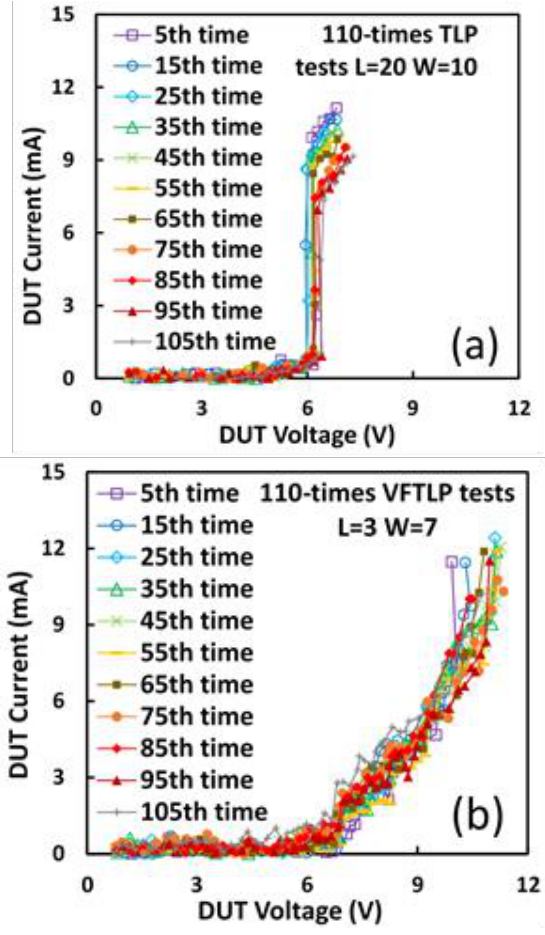
Figure 22. Durability evaluation of single-crystal graphene gNEMS devices by 110-fold ESD stress tests: ( a ) TLP zapping, and ( b ) VFTLP zapping [44].